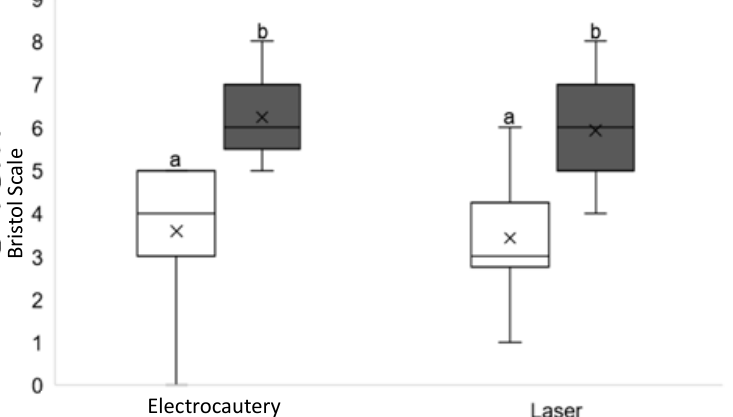
Figure 3. Assessment of ankyloglossia based on Bristol protocol (researcher 2) . White = Before. Black = After.